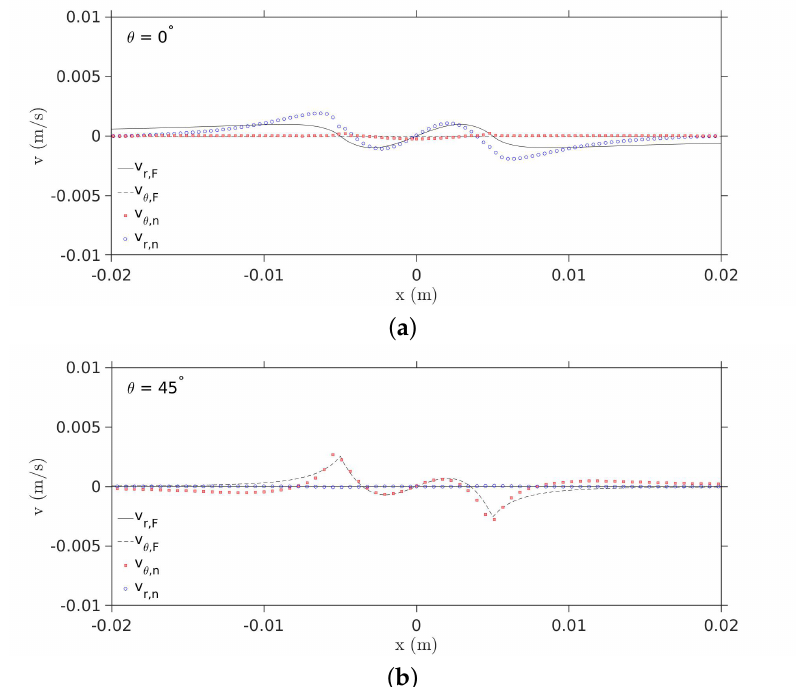
Figure 8. Components of the velocity profile at ( a ) θ = 0 ◦ and ( b ) θ = 45 ◦ compared to the formulae given by Feng